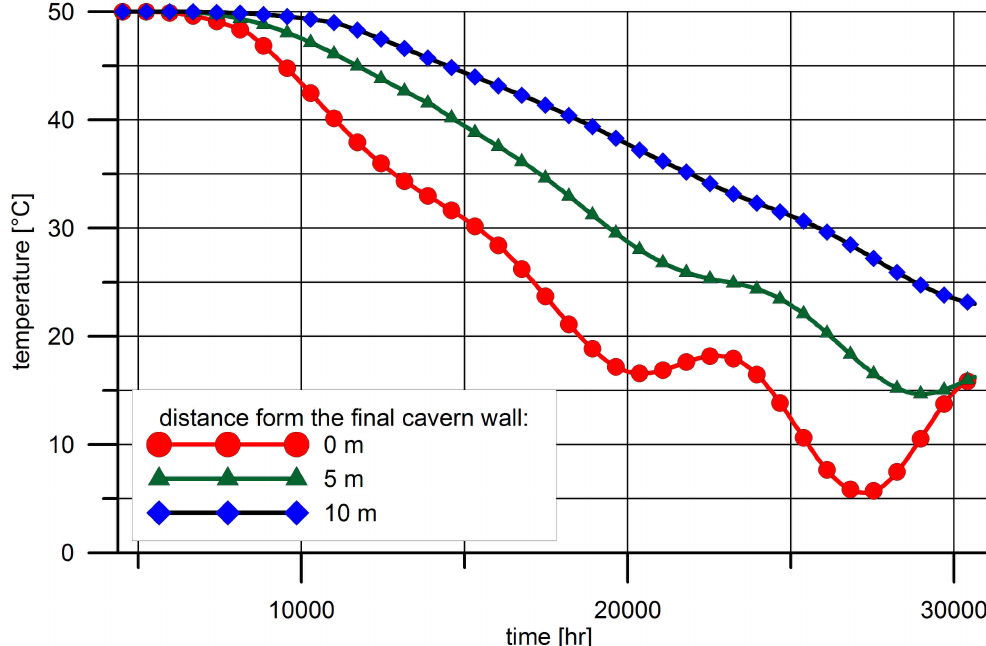
Figure 7. Temperature distribution over time on the target cavern wall and within the rock salt massif—the model in which leaching begins in summer.